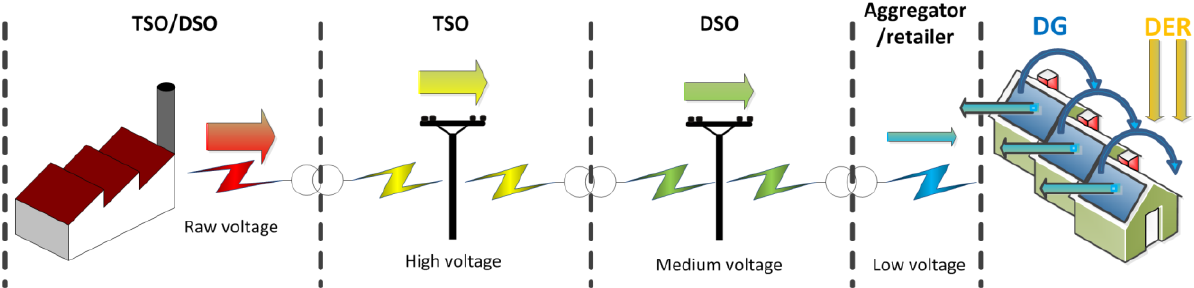
Figure 2. Electricity production, distribution and consumption value chain with a prosumer. DG: distributed generation; DER: distributed energy